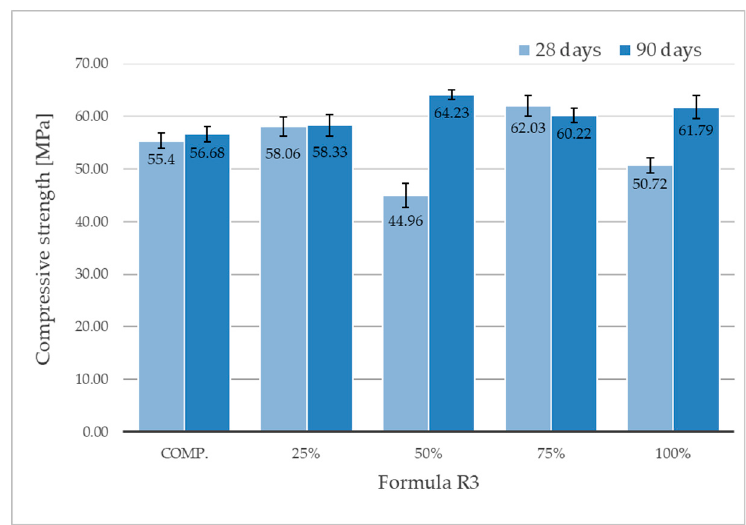
Figure 8. Compressive strength of formula R3 with 25%, 50%, 75% and 100% of mixing water replaced with waste sludge water from the CP.